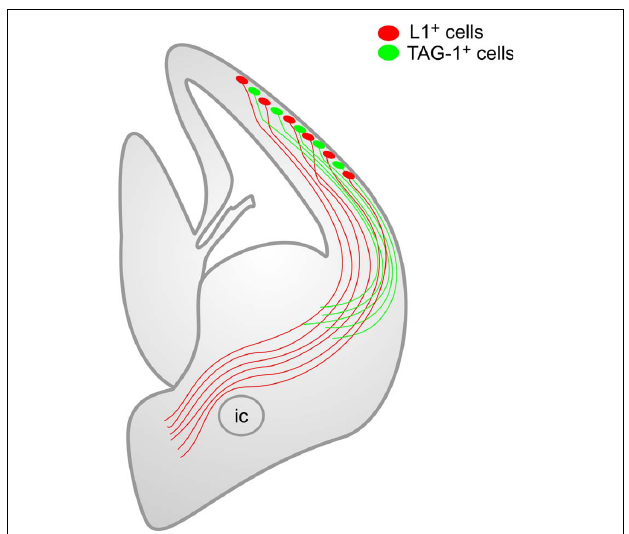
FIGURE 11 | Scheme of the descending corticofugal axonal projections of the two subtypes of non-subplate pioneer neurons at the preplate stage. This scheme highlights the fact that both sets of axons are segregated, although they overlap in a common territory. Note that L1 + axons avoid entering the internal capsule towards the dorsal thalamus. ic, posterior limb of the internal